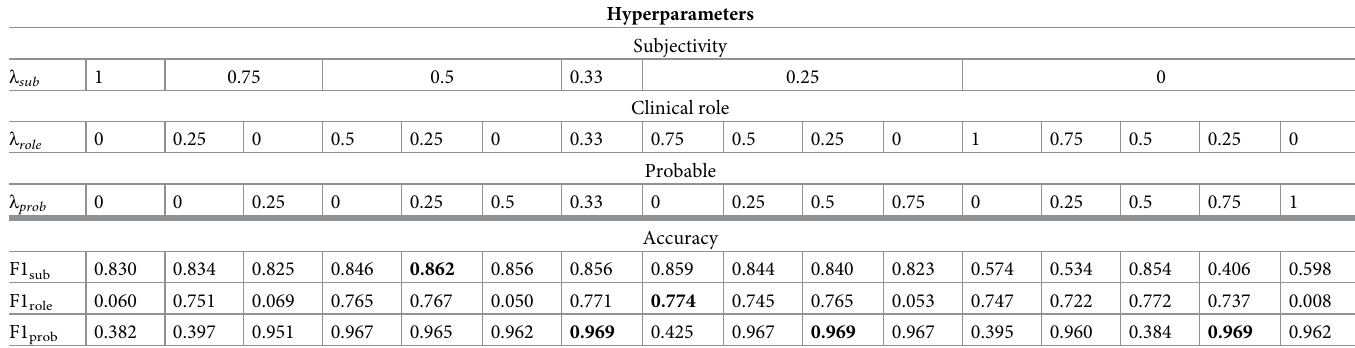
Table 3. Results of a hyperparameter search. Three labeling tasks are conducted as independent tasks, and the weights of the tasks are slid by 0.25 to find the optimal value in multitask learning. Experiments are conducted using dummy